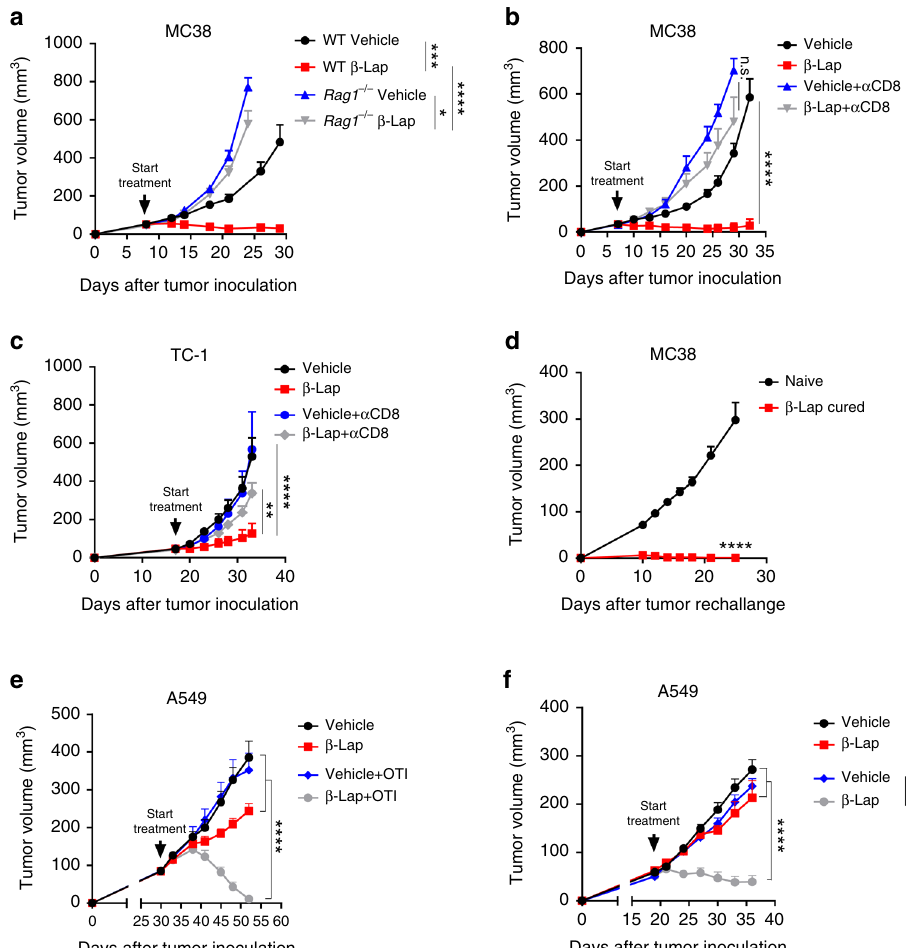
Fig. 2 β -Lap-mediated-antitumor effect depends on CD8 + T cells. a 6 × 10 5 MC38 cells were subcutaneously transplanted into C57BL/6 WT ( n = 5 for vehicle group; n = 6 for β -lap treatment group) and Rag1 − / − mice ( n = 5/group), respectively. Tumor-bearing mice were treated with β -lap (15 mg/kg, i.t.) every other day for four times. Numbers of tumor-free mice after treatment were shown. b C57BL/6 mice ( n = 5/group) were transplanted with 6 × 10 5 MC38 tumor and treated with β -lap (15 mg/kg, i.t.) every other day for four times. For CD8 + T cell depletion, 200 μ g of anti-CD8 antibodies were intraperitoneally injected four times at three days interval during the treatment. c C57BL/6 mice were transplanted with 1.5 × 10 5 TC-1 tumor cells and were treated with β -lap (5 mg/kg, i.t.) for four times with or without anti-CD8 antibodies ( n = 5 for β -lap treatment group; n = 4 for vehicle, vehicle + α CD8, and β -lap + α CD8 groups). d Naïve ( n = 5/group) and β -lap cured MC38 tumor-free ( n = 7/group) C57BL/6 mice were rechallenged subcutaneously with 3 × 10 6 MC38 cells on the opposite site from the primary tumor 30 days after complete rejection, and tumor growth curve was monitored. e 2 × 10 6 A549 cells were subcutaneously injected into C57BL/6 Rag1 − / − mice ( n = 5 for vehicle and β -lap groups; n = 6 for vehicle + OTI group; n = 7 for β -lap + OTI group). Thirty days later, the mice were i.v. adoptively transfected with 2 × 10 6 lymph node cells from OT-1 transgenic mice. On the following day, tumor-bearing mice were intratumorally treated with β -lap (10 mg/kg) every other day for four times. f 2 × 10 6 A549 cells were subcutaneously injected into NSG-SGM3 ( n = 5/group) or NSG-SGM3 harboring human CD34 + hematopoietic stem cells ( n = 5 for Hu-NSG vehicle group; n = 6 for Hu-NSG β -lap group). Tumor-bearing mice were treated with β -lap (10 mg/kg, i.t.) every other day for four times. Tumor growth was measured twice a week. Data are shown as mean ± SEM from three independent experiments. ** p < 0.01, **** p < 0.0001 determined by unpaired Student's t -test in a and b , or two-way ANOVA in c –